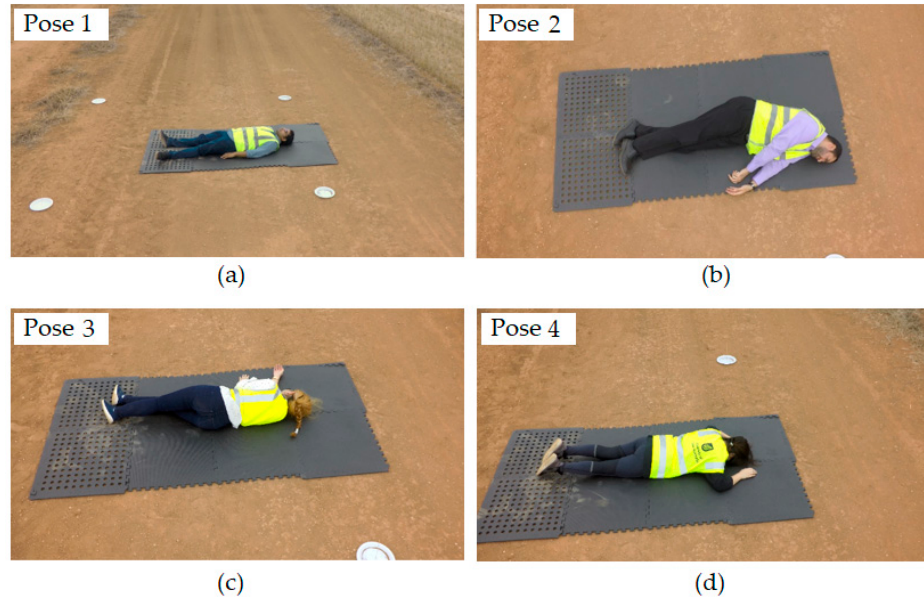
Figure 8. Subjects at different poses ( a ) Pose 1: back position, ( b ) Pose 2: side position facing the camera, ( c ) Pose 3: side position non-facing the camera, and ( d ) Pose 4: stomach position.